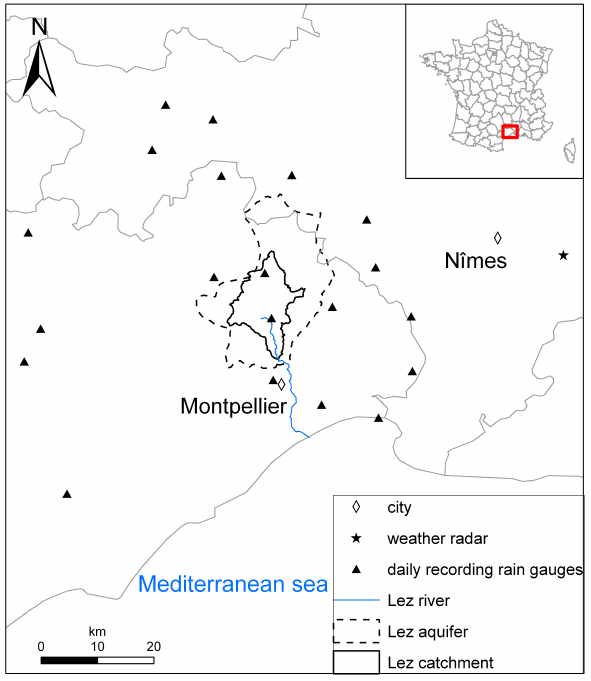
Fig. 4. Location of the Nˆımes weather radar and the 20 daily rain